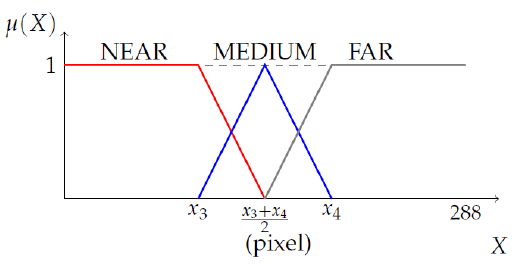
Figure 11. Membership functions for pedestrian’s distance (PedDist): The value of x 3 and x 4 are determined by the x-coordinate of two lines in the transformed 3D image.